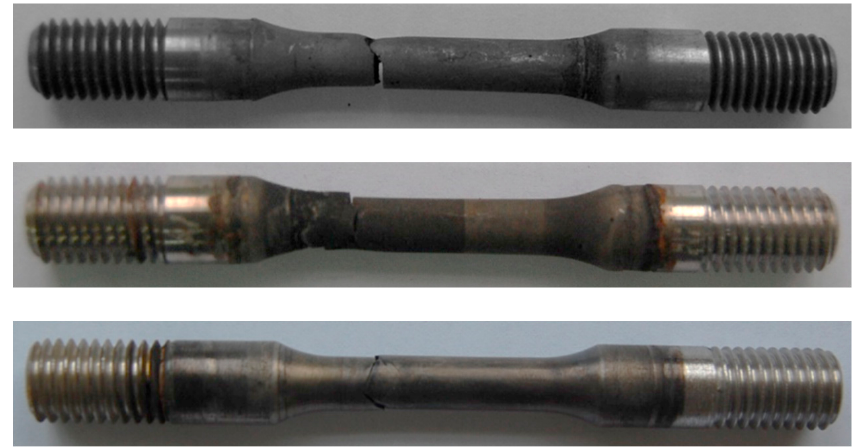
Figure 7. SSC evaluation test specimens of steel B.